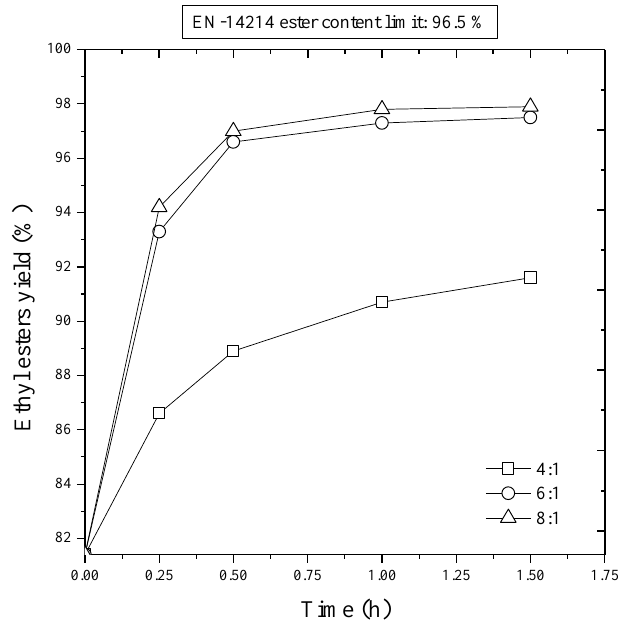
Figure 5. Second stage transesterification. Effect of the molar ratio of ethanol to sunflower oil on ethyl ester yield. NaOH/oil mass ratio, 0.75%; reaction temperature, 80 °C.